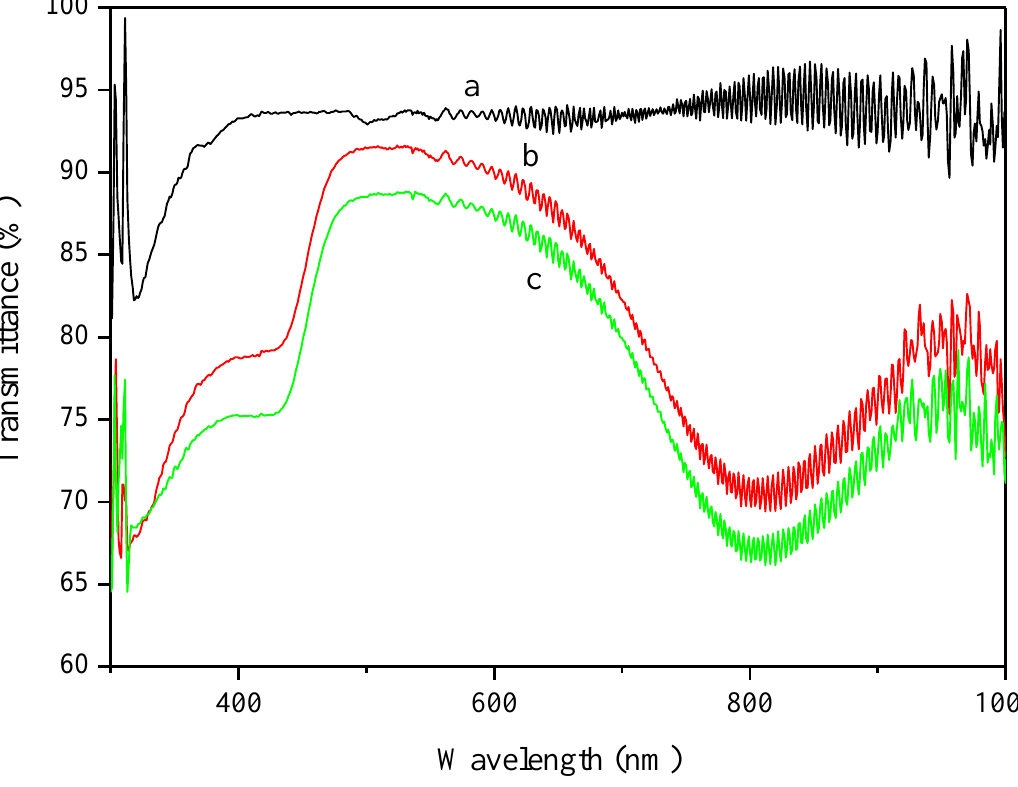
Figure 8. Transmittance spectra of ( a ) pure UV coating; ( b ) UV coating / 5 wt% PANDB conductive composite film; and ( c ) UV coating / 10 wt% PANDB conductive composite film deposited on PET sheets (using PET sheet as background).